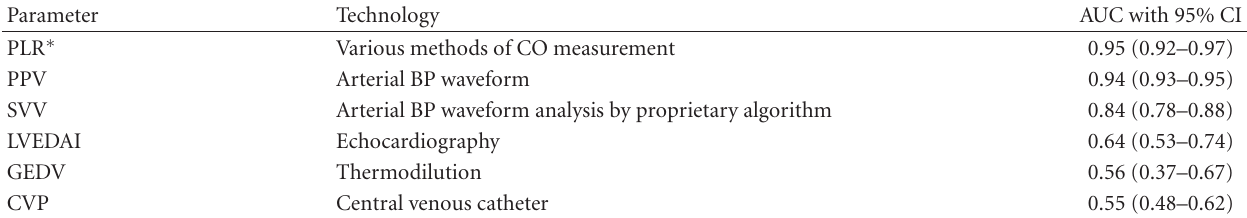
Table 1: Accuracy of various parameters used to predict preload responsiveness [7,